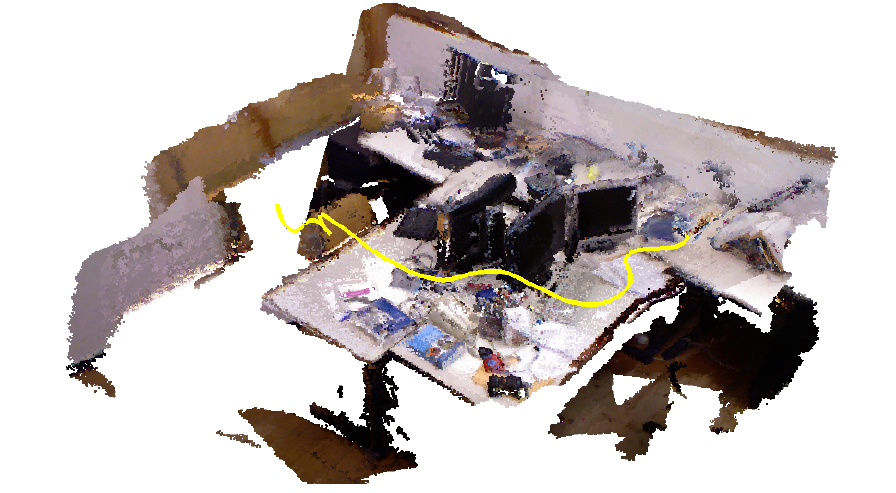
Figure 5. Example of the ground-truth point cloud reconstruction of the first 200 frames of the “fr1 desk” sequence; the yellow line represents the movement of the